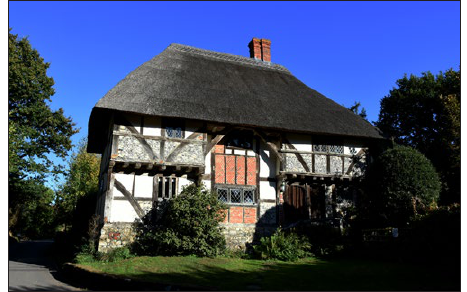
Figure 8: The late C.15 th Yeoman’s House at Bignor, 11.5 km to the east of Downley (Figure 15). Photo: